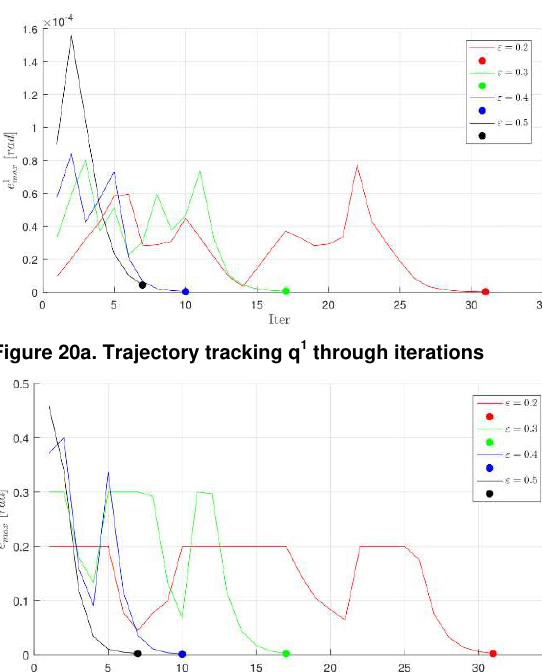
Figure 20b.Trajectory tracking q 2 through iterations